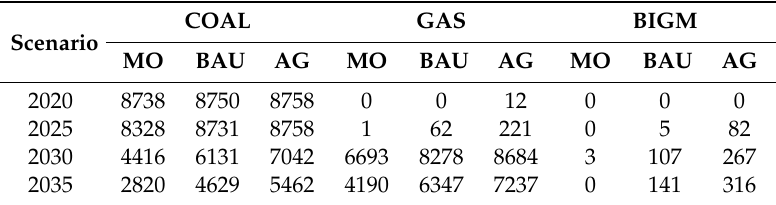
Table 13. Comparison of the annual operating hours of COAL, GAS and BIGM in the electricity market part under the MO, BAU and AG electricity marketization scenarios.